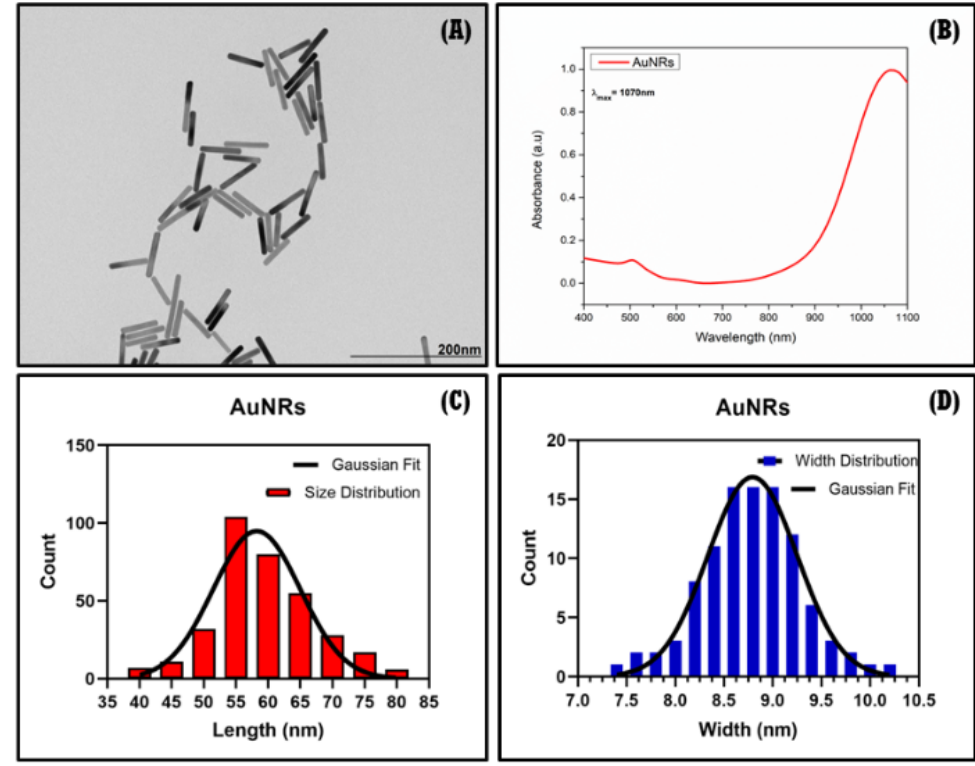
Figure 11. TEM images ( A ), UV-Vis NIR-II spectra ( B ), and size distribution of AuNRs ( C , D ).